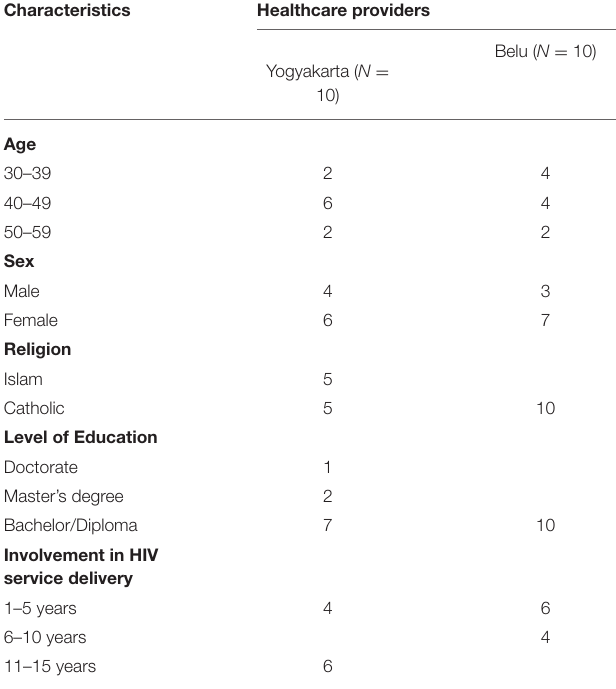
TABLE 1 | Sociodemographic profile of healthcare